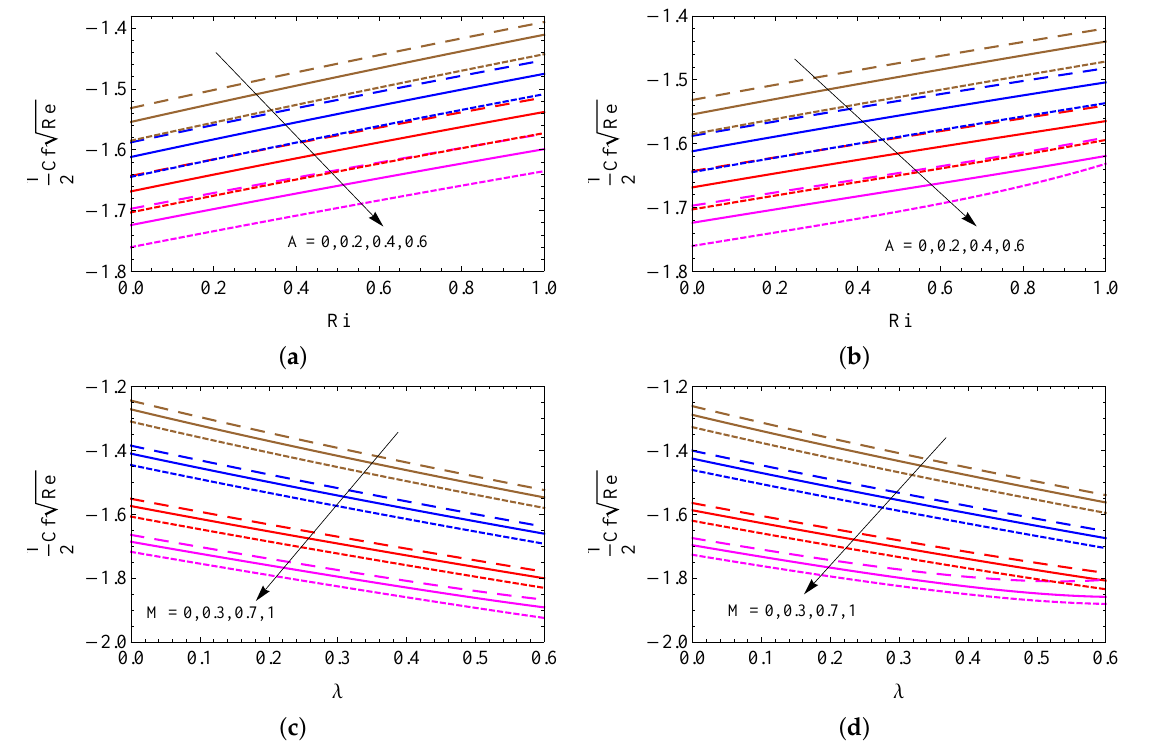
Figure 7. The contrast of the skin friction coefficient for different combinations of A and Ri ( a , b ) and M and λ ( c , d ) with convective heating ( a , c ) and convective cooling ( b , d ) cases for SWCNTs (solid line), MWCNTs (dashed line) and Al 2 O 3 nanofluid (dotted line).